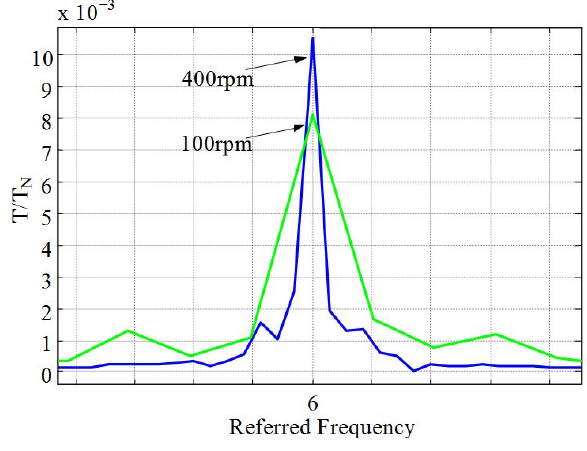
Figure 8. Measured torque harmonic at a load of 150 Nm [6].